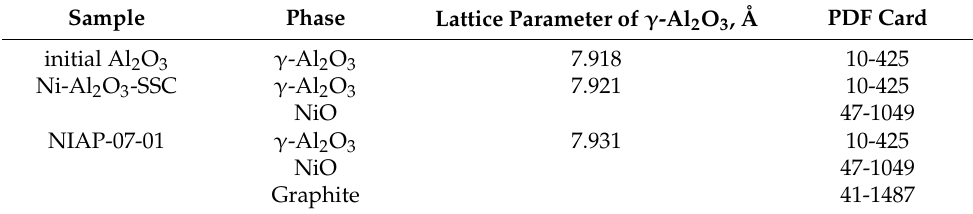
Table 2. The phase composition of Ni-Al 2 O 3 -SSC and NIAP-07-01 catalysts.